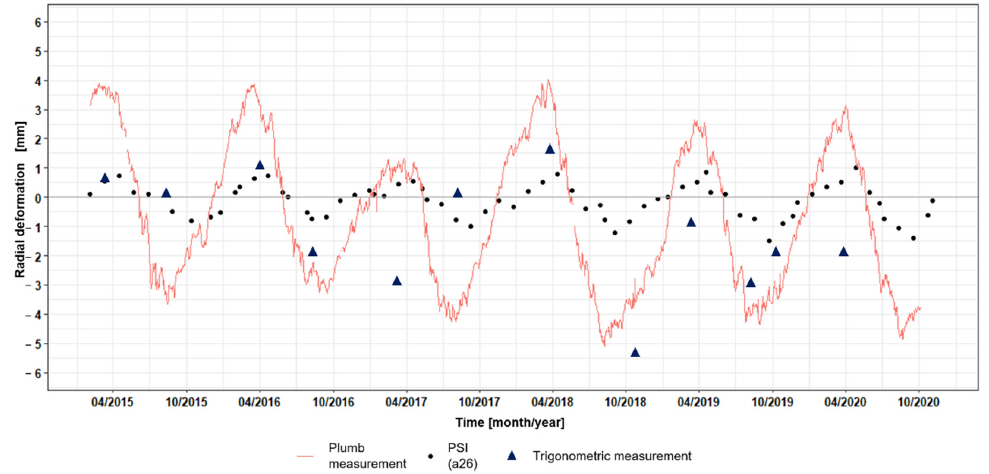
Figure 11. Deformation profile of a PS point (a26) located at the dam’s lower part and the compari- son with in situ measurements. with in situ